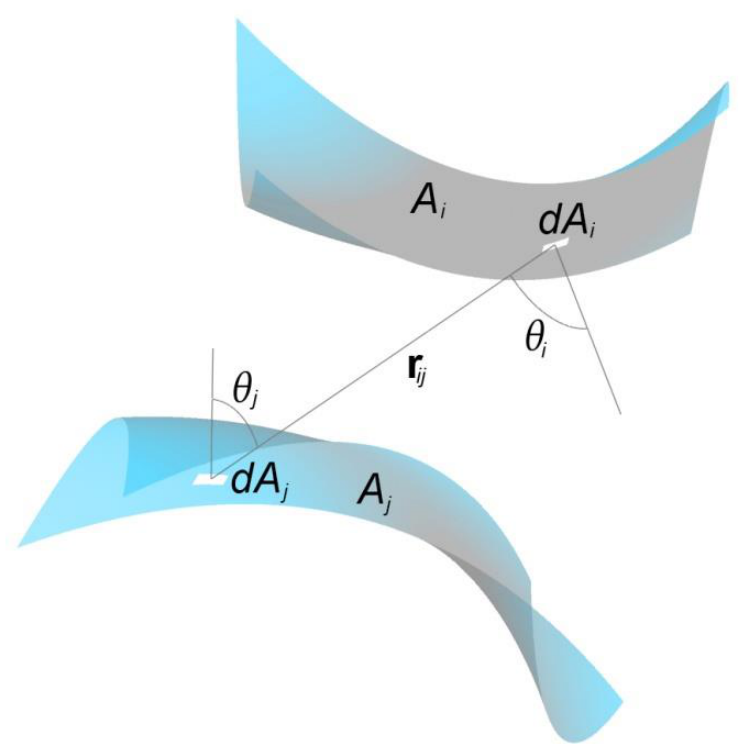
Figure 1. Arrangement of surface-source elements. Source: Salguero-Andujar. The magnitudes θ i and θ j correspond to the angles enclosed by the normal lines to the unit areas dA i and dA j (Figure 1), where r ij stands for an arbitrary distance that colligates the unit surface sources dA i and dA j .